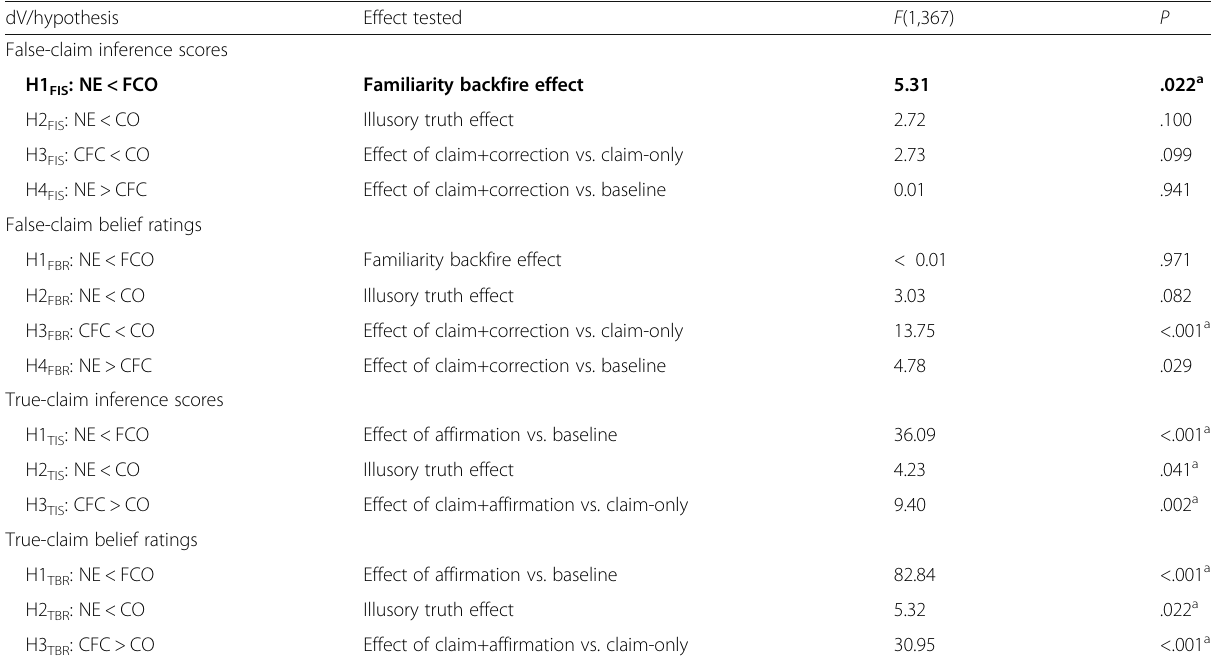
Table 1 Contrasts run in Experiment